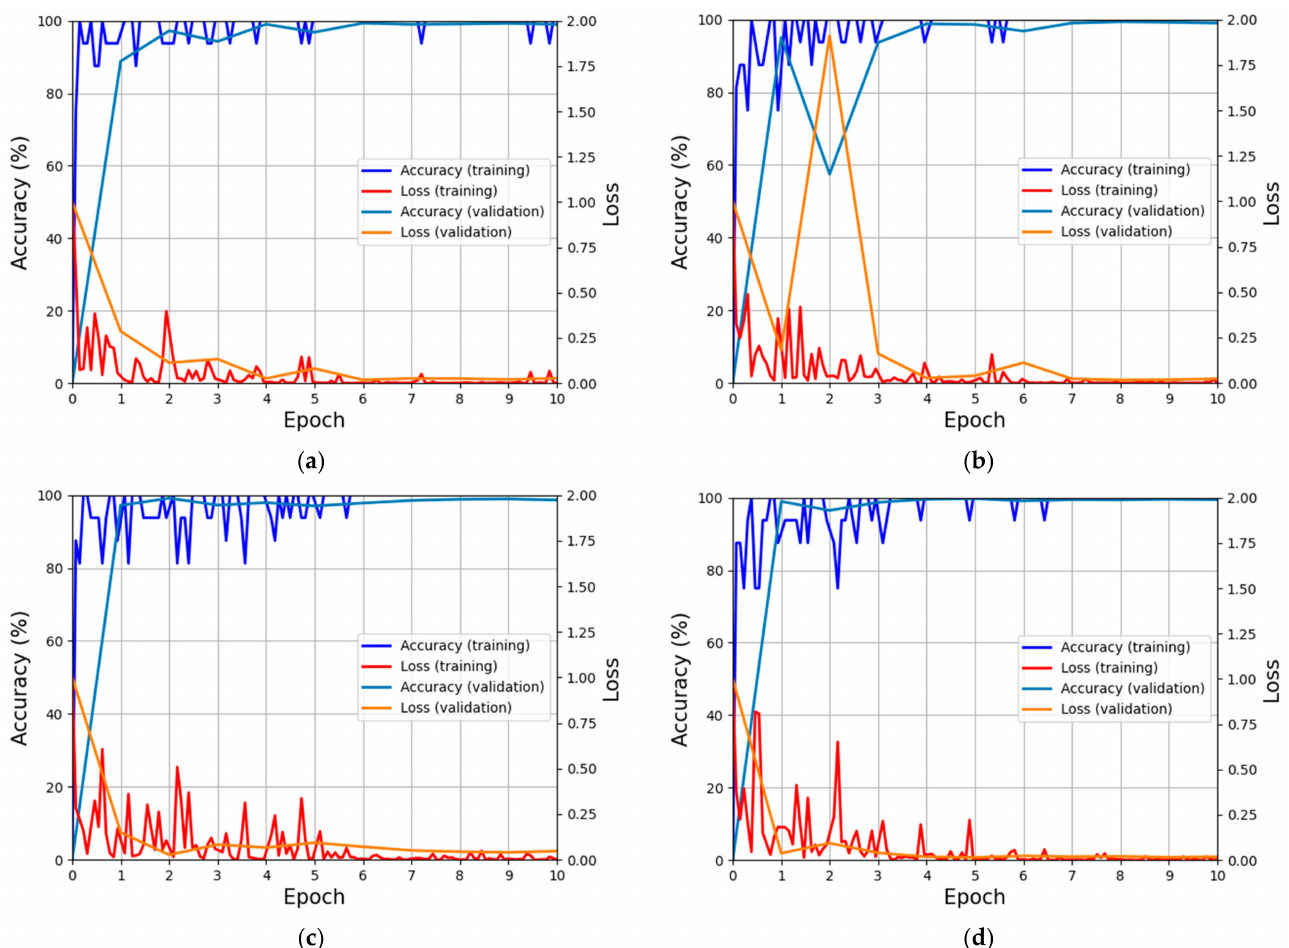
Figure 8. Training, validation loss, and accuracy graphs with DBPerson-Recog-DB1 dataset. ( a , b ) are training and validation graphs of the original DenseNet for ( a ) fold 1 and ( b ) fold 2. ( c ) and ( d ) are training and validation graphs of the attention-guided DenseNet for ( c ) fold 1 and ( d ) fold 2.